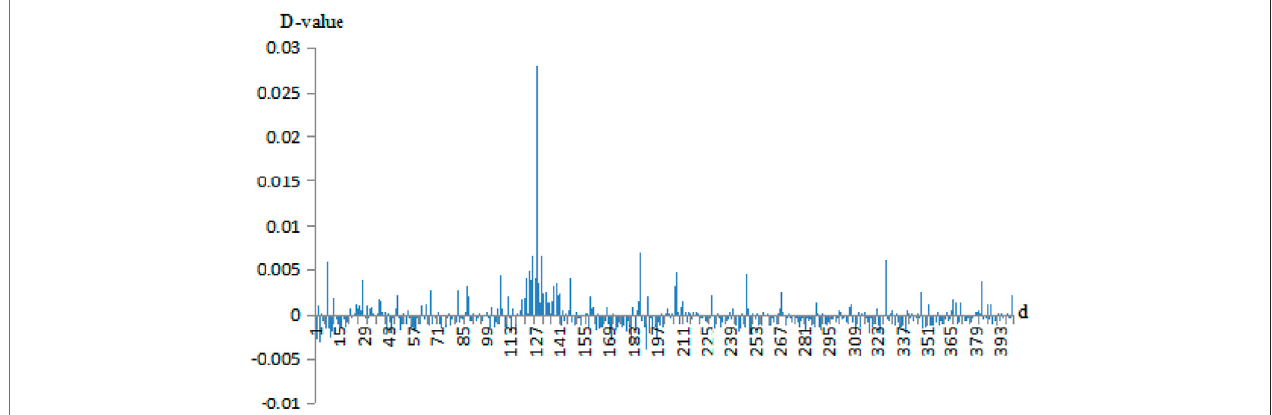
FIGURE3 | The probability difference of the secondary neighbor correlation ofCu 2+ positive and negativefragments. Note: the abscissa 1 – 400 isAA, AC, AD, ... , AY, CA, CC, CD, ... , CY, ... , YA, YC, YD, ... , YY. The ordinate is the D-values of the positive sets minus the negative